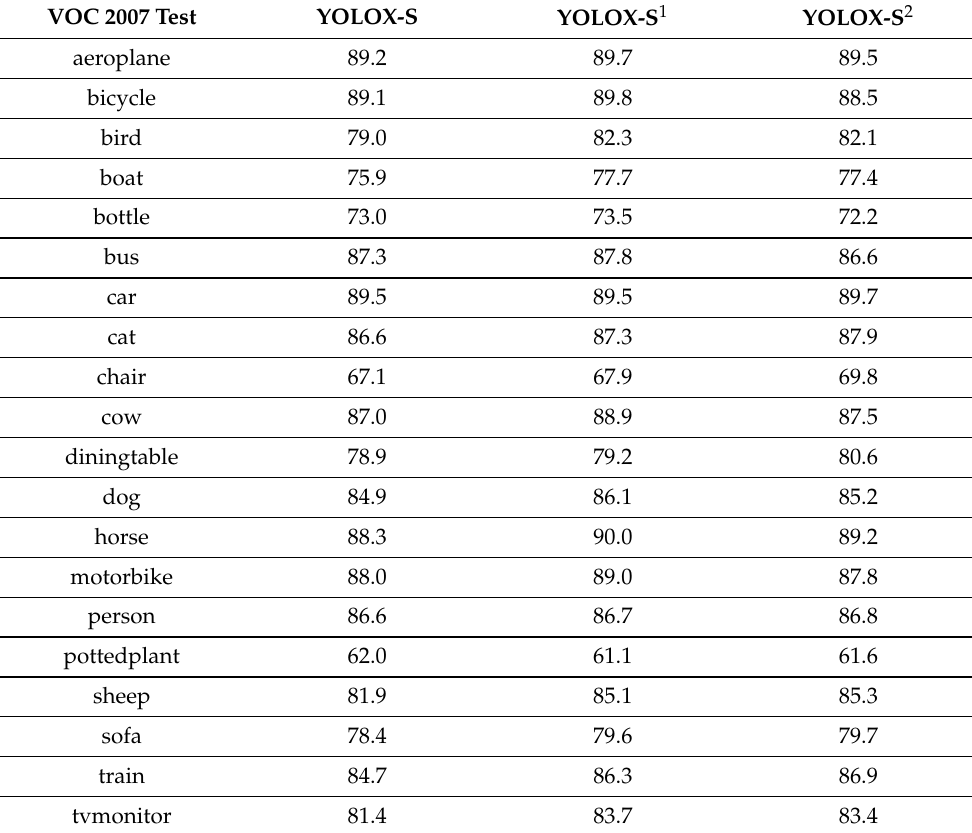
Table 4. Precision values for all classes on the PASCAL VOC 2007 test set for each